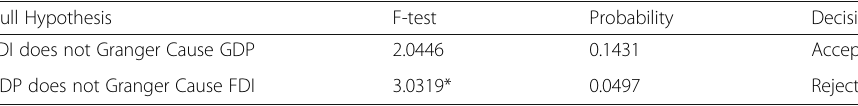
Table 7 Results of Granger Causality Null